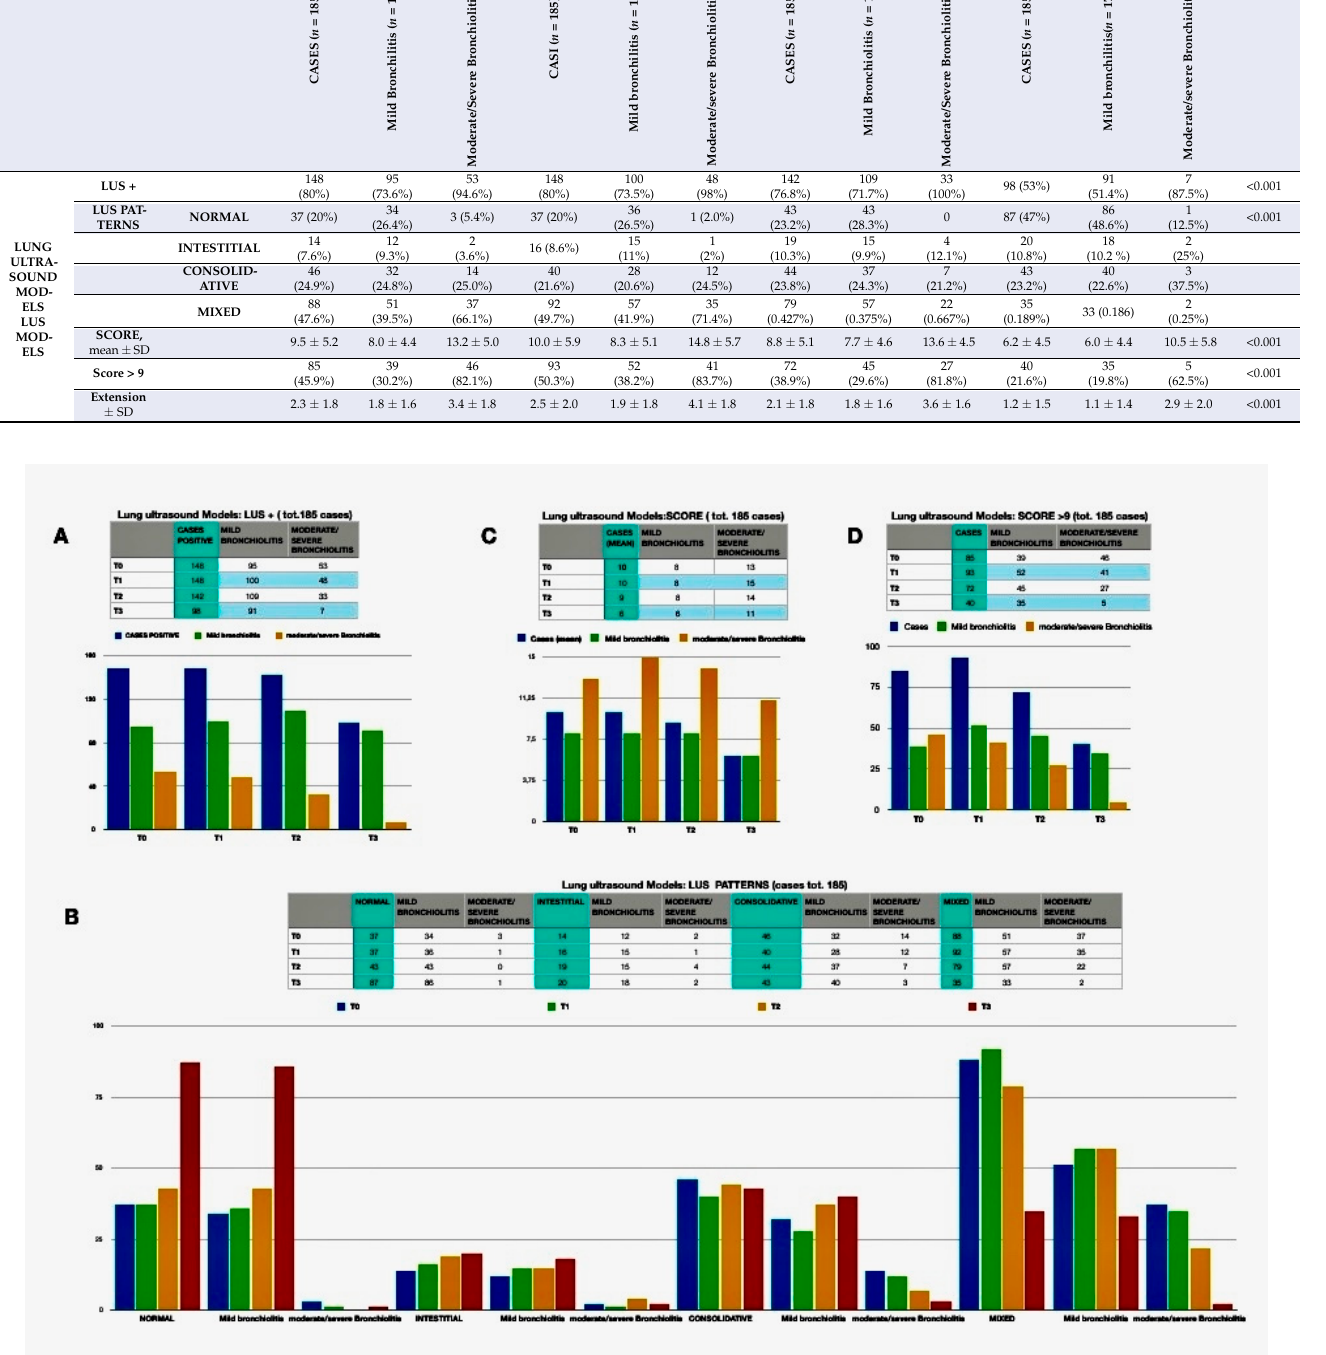
Figure 5. Lung Ultrasound (LUS) patterns at baseline and during follow-up. ( A ) shows changes in number of children with positive LUS; ( B ) shows changes in type of patterns; ( C ) shows changes in mean scores; ( D ) shows number of children with a LUS score higher than 9.